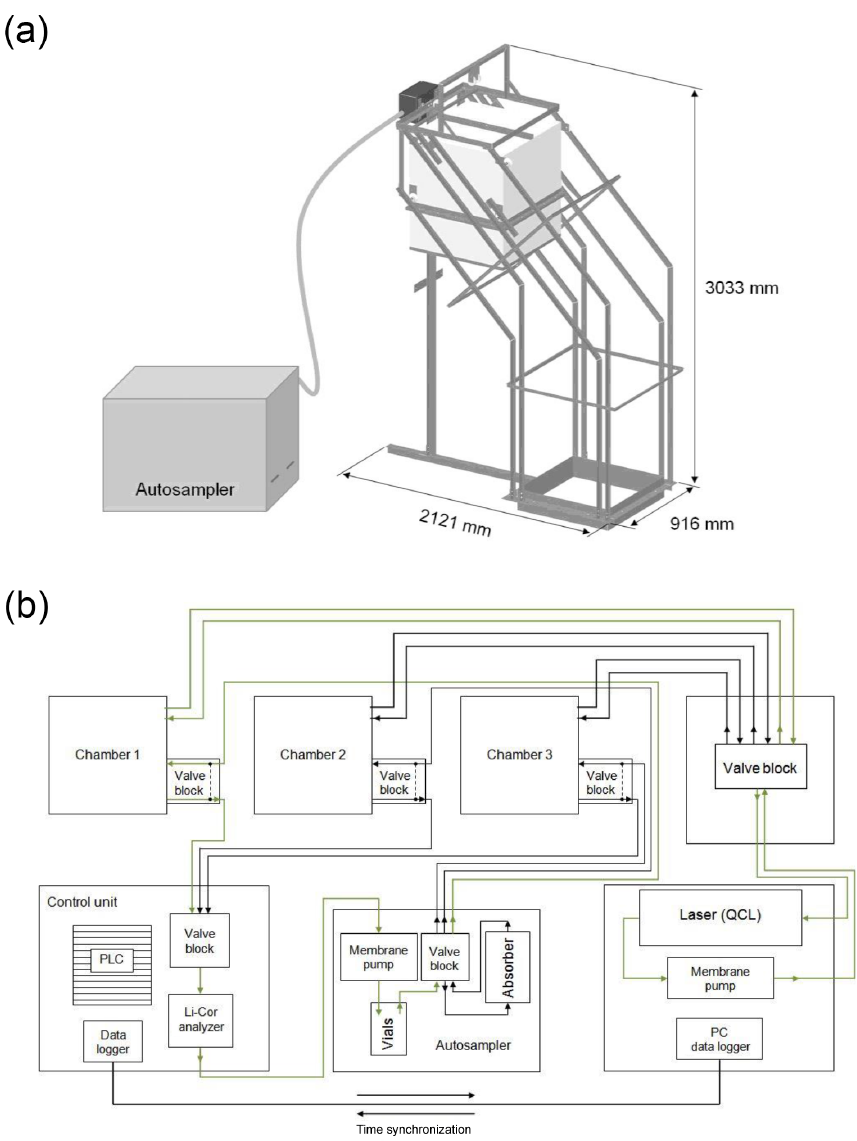
Figure 1. Schematic diagrams of an automated chamber connected to an autosampler unit (a) and of the entire chamber system (b) . Green lines indicate that Chamber 1 is currently in measurement mode. See text for detailed